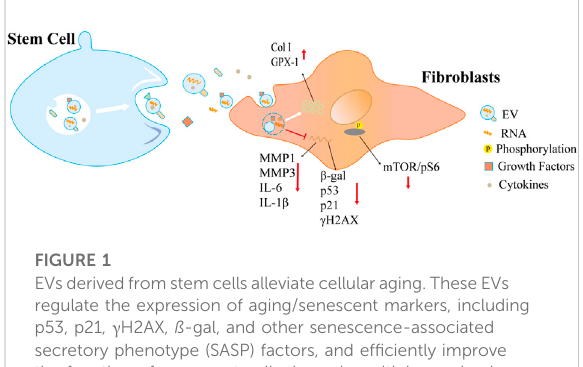
FIGURE 1 EVsderivedfromstemcellsalleviate cellularaging.TheseEVs regulate the expression of aging/senescent markers, including p53, p21, γ H2AX, ß -gal, and other senescence-associated secretory phenotype (SASP) factors, and ef fi ciently improve the function of senescent cells through multiple mechanisms.